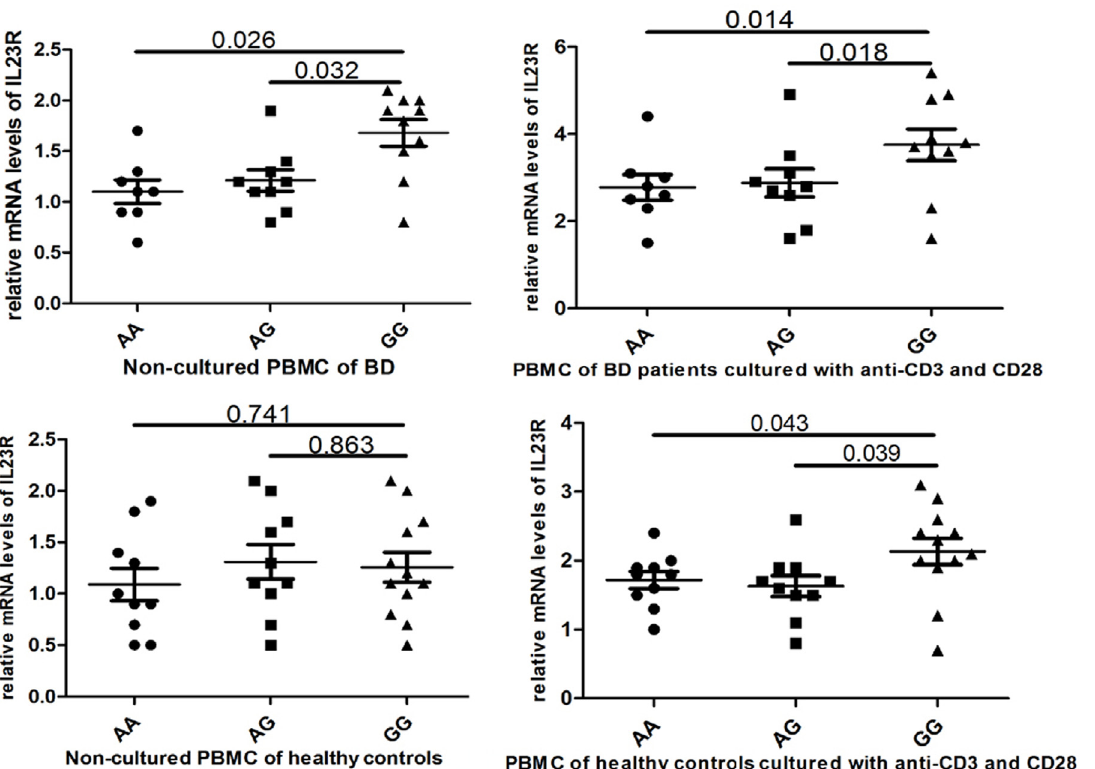
Fig 1. Relative IL-23R subunit expression levels of peripheral blood mononuclear cells (PBMC) obtained from healthy individuals and patients with Behcet ’ s disease with the rs17375018 AA, AG and GG genotypes.